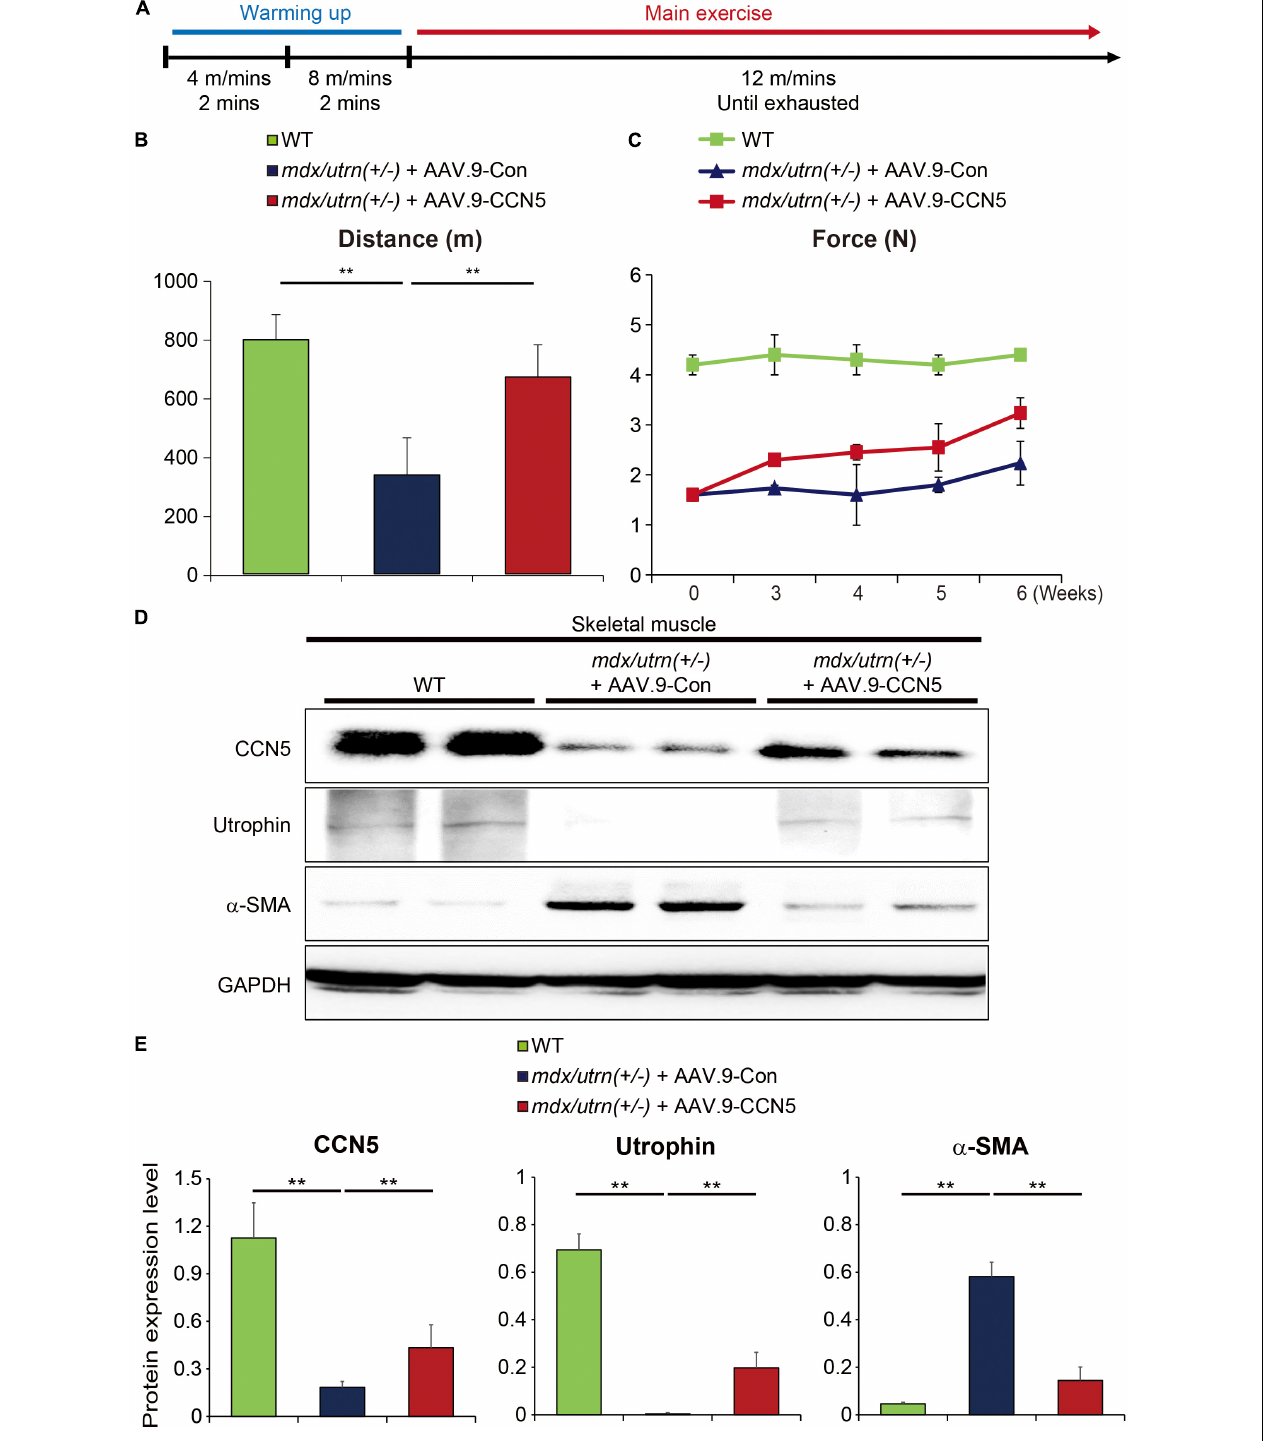
FIGURE 3 | CCN5 enhances exercise performance of mdx/utrn ( ± ) mice. (A) Experimental scheme for panel (B) . Mice were injected with AAV.9-Con or CCN5 into the tail vein, and treadmill tests were performed 8 weeks later. Warming up exercises were serially performed at 4 m/min for 2 min and 8 m/min for 2 min. Main exercise was performed at 12 m/min until the mice were exhausted. (B) Total running distance was measured by calculating running time and velocity. (C) Comparison of grip strength tests was performed after AAV.9-Con or CCN5 injection. (D) Proteins from skeletal muscle tissue were immunoblotted with antibodies against CCN5, utrophin, α -SMA and GAPDH. (E) Protein bands on western blots were scanned and plotted. n = 6. ** p < 0.01.